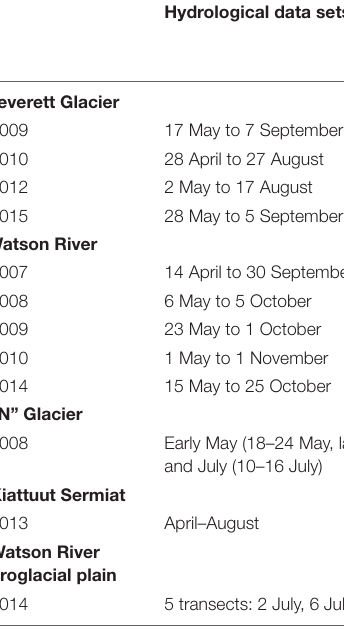
TABLE 1 | Geochemical samples summary collected in each ablation season from GrIS catchments. Hydrological data sets Dissolved cations (Ca 2 +